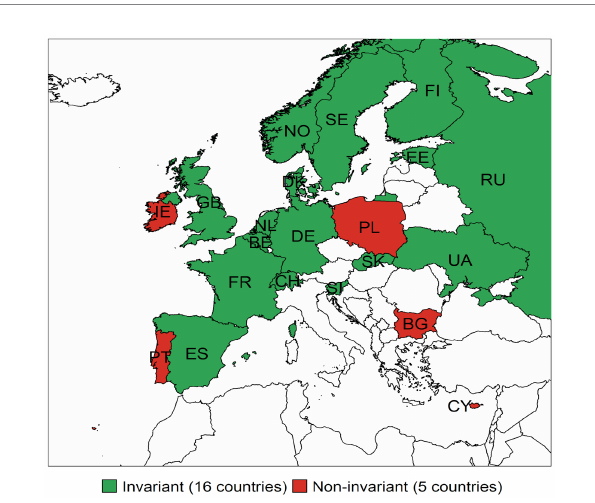
FIGURE 1 Countries with full intercept invariance on the measure of Positive Affect across time (Round 3–Round 6). The figure displays the countries where the full scalar invariant model holds across time points for countries present at both ESS rounds. The countries where PA was not fully invariant across time were Cyprus, Bulgaria, Poland, Ireland and Portugal.